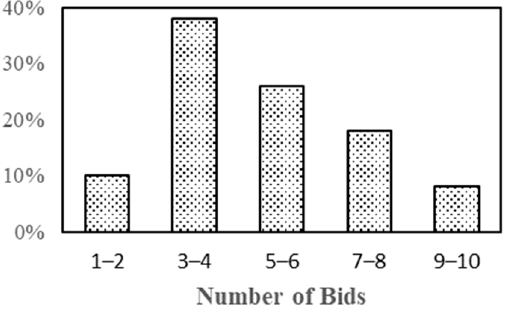
Figure 1. Distribution of bidders per project.